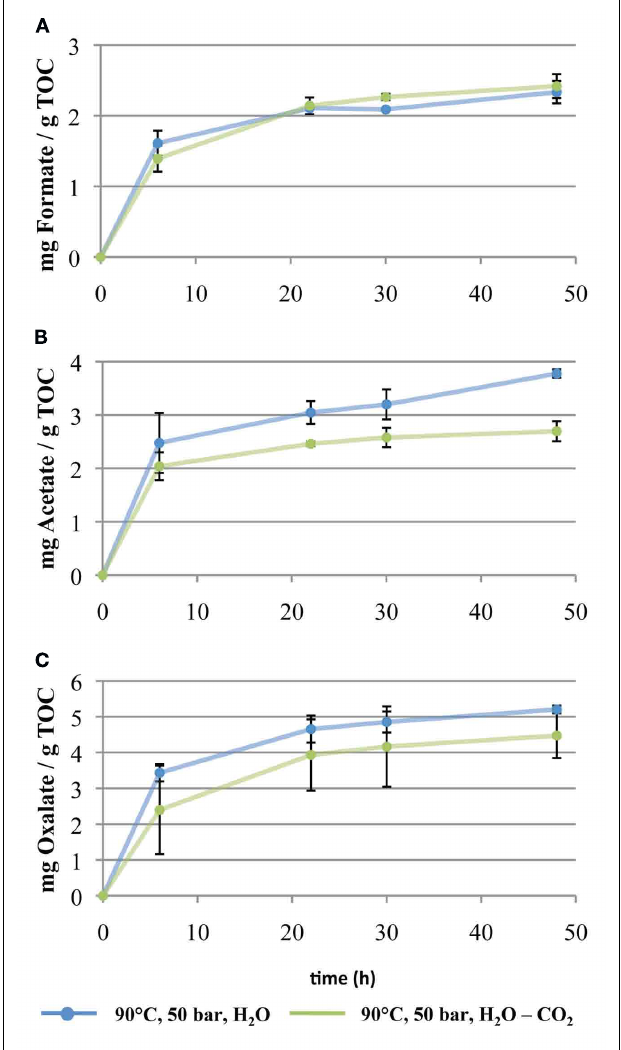
FIGURE 4 | Extraction of (A) formate, (B) acetate, and (C) oxalate from sub-bituminous coal sample taken from the DEBITS-1 well atWaikato CoalArea, North Island, New Zealand. Five grams of coal (approximately 30%TOC) were extracted for 48h at 5MPa and 90˚C. Extractions were performed with water (blue circles) and water–carbon dioxide mixture (green triangles). Sample analysis was performed by ion